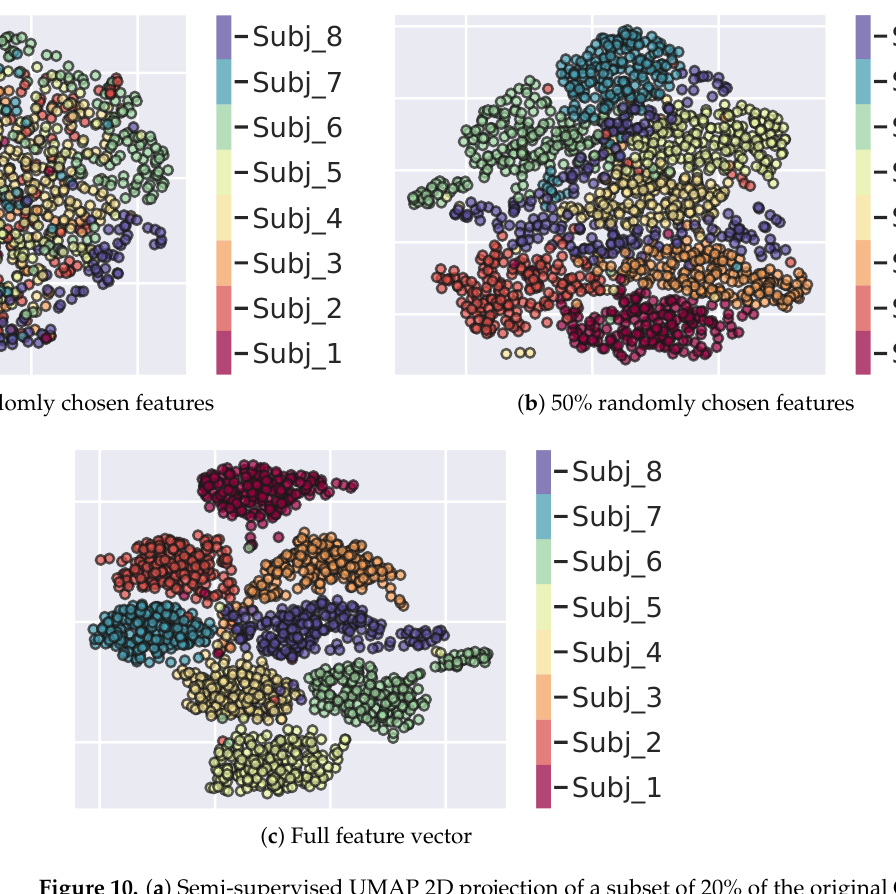
Figure 10. ( a ) Semi-supervised UMAP 2D projection of a subset of 20% of the original O-U parame- ters. ( b) Semi-supervised UMAP 2D projection of a subset of 50% of the original O-U parameters. ( c ) Projection obtained by using the full feature vector. In the ( a , b ) cases, the subset of features is constructed by selecting features at random via uniform distribution sampling. Each point represents a subject (identified by a colour in the side bar) observing a specific